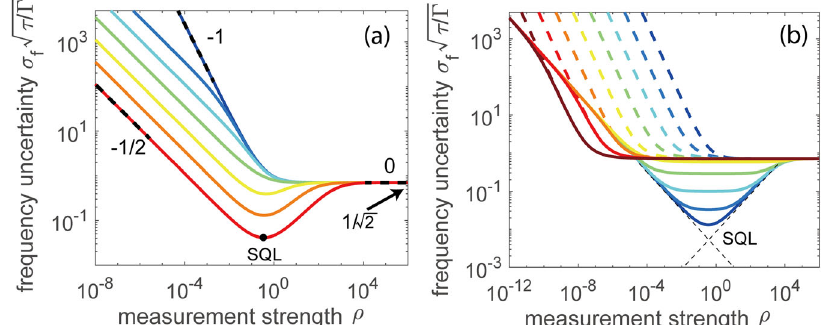
Fig. 2 Quantum limited frequency uncertainty for long measurement times. a Zero-temperature case ( T = 0). From the blue to red lines, O j j 2 ¼ 0 ; 10 (cid:2) 2 ; 10 (cid:2) 1 ; 10 0 ; 10 1 ; 10 2 ; 10 3 , respectively. For a strong coherent external drive, the Standard Quantum Limit (SQL) minimum at optimal x 2 ZPM measurement strength is evident. With the weaker drive, a transition occurs, whereby the stochastic measurement backaction becomes the dominant excitation to the system, and the system ’ s response to backaction is the dominant source of the frequency information (slope becomes -1). Dashed black lines are guides for the eye, depicting constant, linear, and square-root dependencies in the log – log plot. b Finite-temperature cases, with (solid lines O j j 2 increases the driven system uncertainty in the vicinity of the SQL, but only until the increased stochastic thermal force overtakes the drive. Larger thermal excitation at higher temperatures improves the frequency measurement in the low measurement strength regime. The detuning is set to be 0, 2 Δ ω Γ ¼